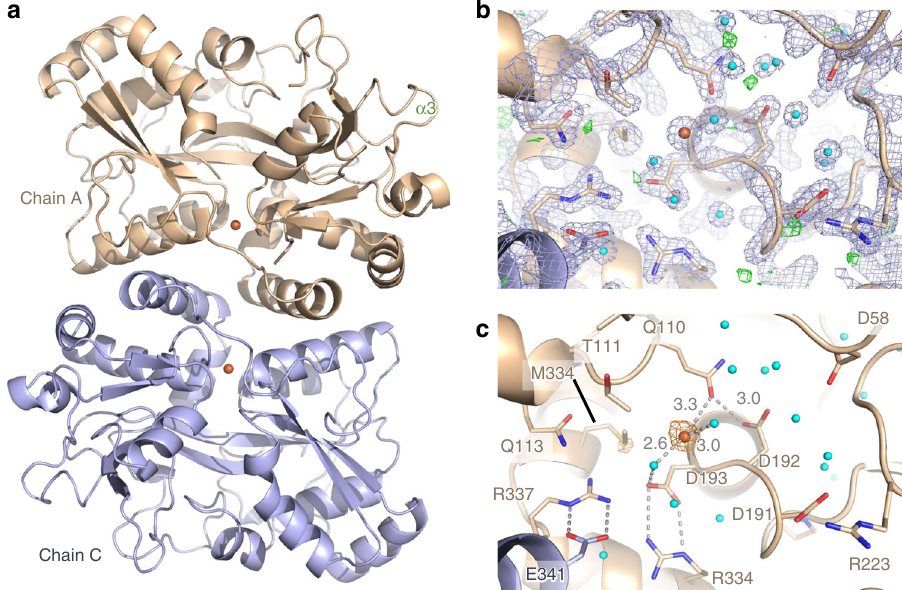
Fig. 5 Structure of Fe-IbpS. a Cartoon representation of Fe-IbpS dimer with iron atom (orange sphere) bound to chain A (wheat) and C (light blue). b Close-up view of the iron-binding site in chain A. The structure is depicted in ball-and-stick with water molecules and iron atom represented as spheres colored in cyan and orange with an overlay of 2F o – F c electron density (blue mesh, contoured at 2.0 σ ) and F o – F c map (green mesh, contoured at 3 σ ). c Same view as b with an overlay of the anomalous electron density map contoured at 4 σ (orange mesh). Interactions at the iron-binding sites are shown as gray dashed lines and distances are indicated in Å